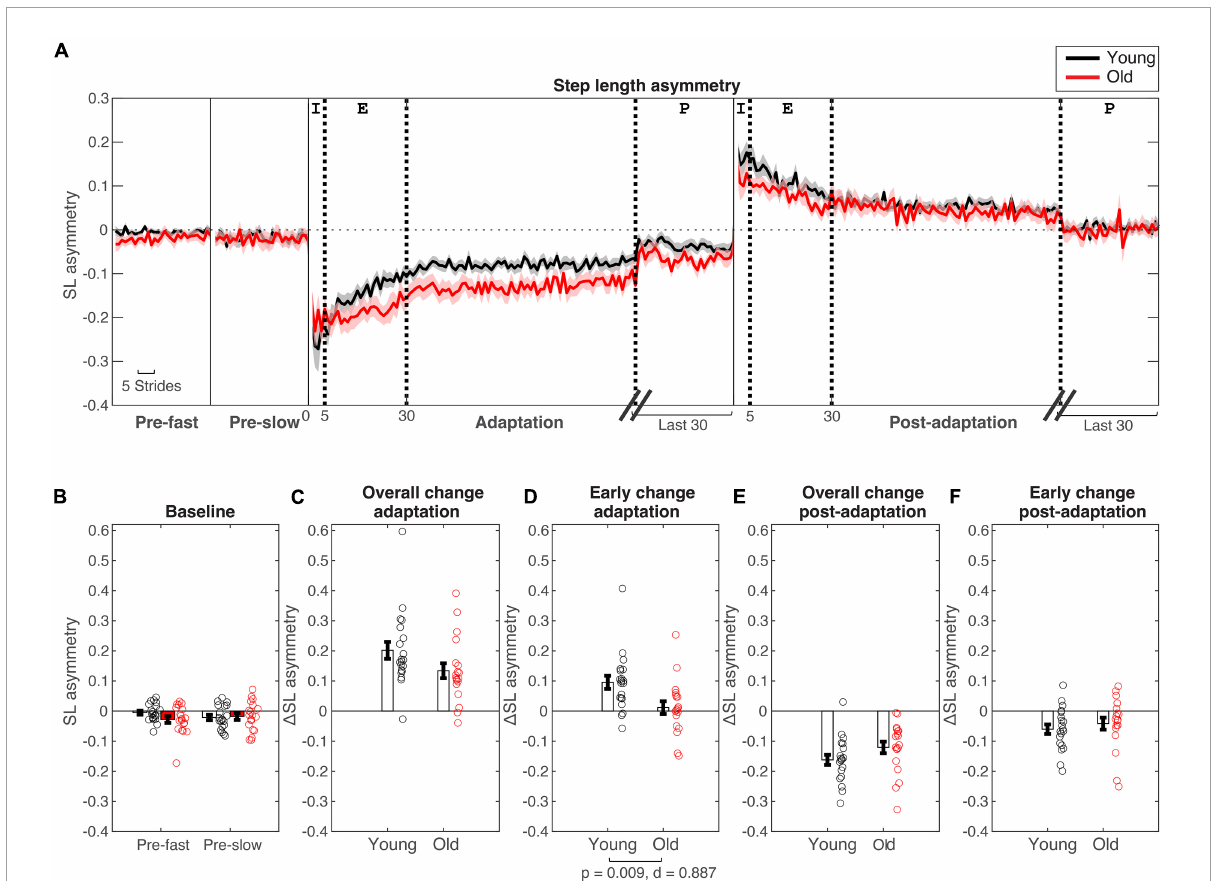
FIGURE2 Step length asymmetry changes during split-belt adaptation. (A) Stride-by stride changes in step length asymmetry plotted for young (in black) and older adults (in red). Shaded areas are standard errors. For baseline (“pre-”) conditions the first 30 strides are plotted. For adaptation and post-adaptation conditions, the first 100 and last 30 strides are plotted. Thick dotted lines are for stride numbers 5, 30, and 100/30 strides before the last stride to indicate the different epochs [Epochs indicated at top of A: Initial (I) = Strides #1–5, early (E) = Strides #6–30,